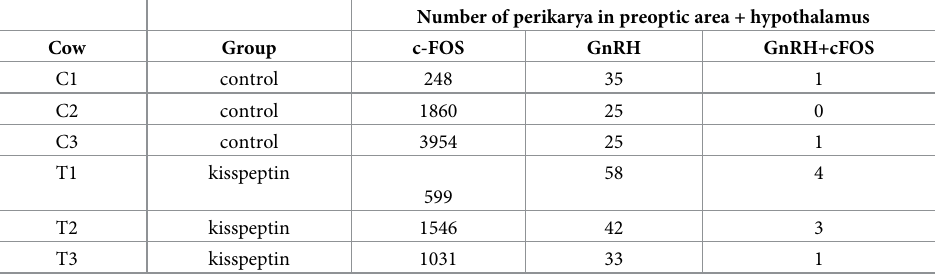
Table 2. Number of neurons expressing immunoreactivity for c-FOS positive perikarya (c-FOS), GnRH positive perikarya (GnRH) and GnRH neurons bodies that co-expressed cFOS protein (c-FOS and GnRH in the preoptic and hypothalamic area of cows 150 minutes after initiation of treatment with kisspeptin or saline (Time 0 = first